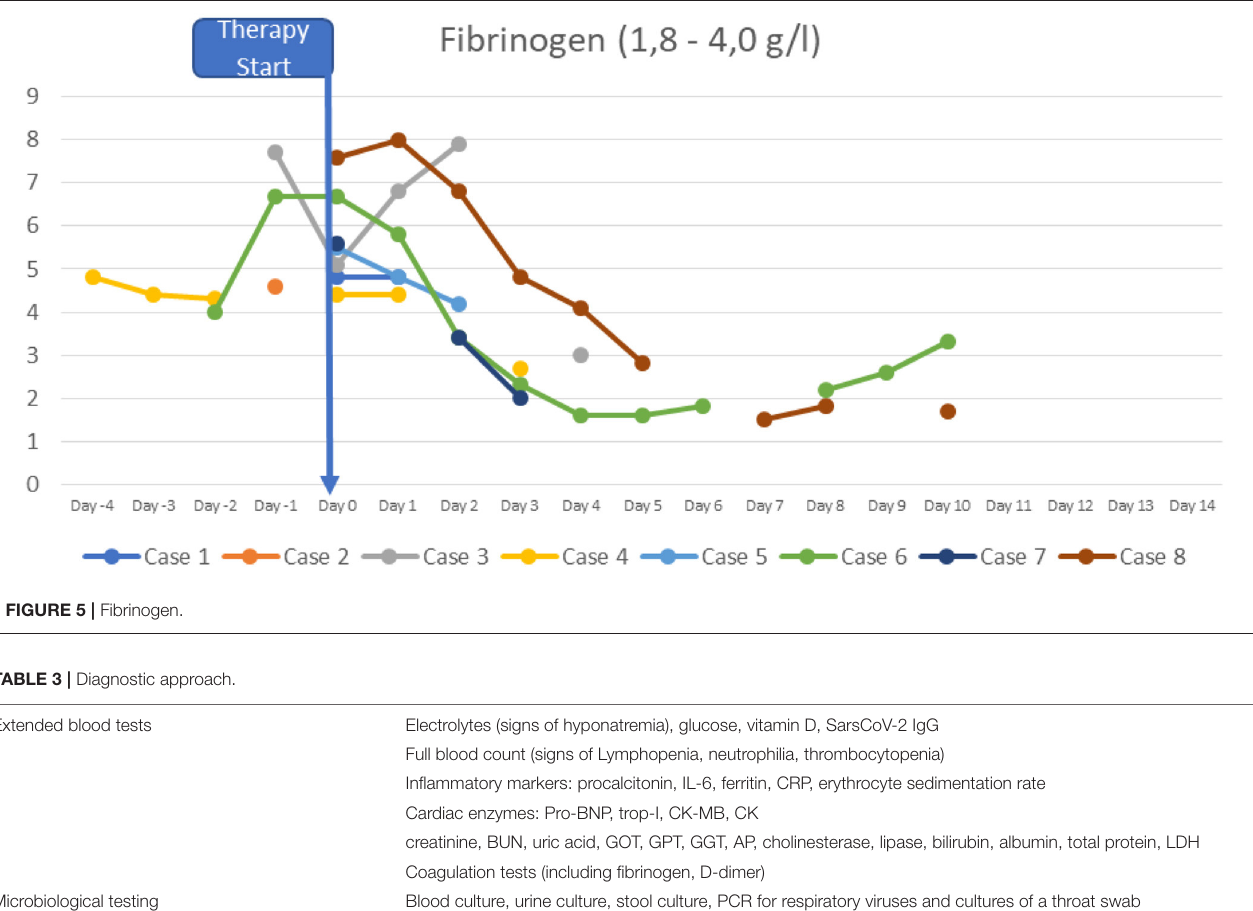
TABLE 3 | Diagnostic approach.